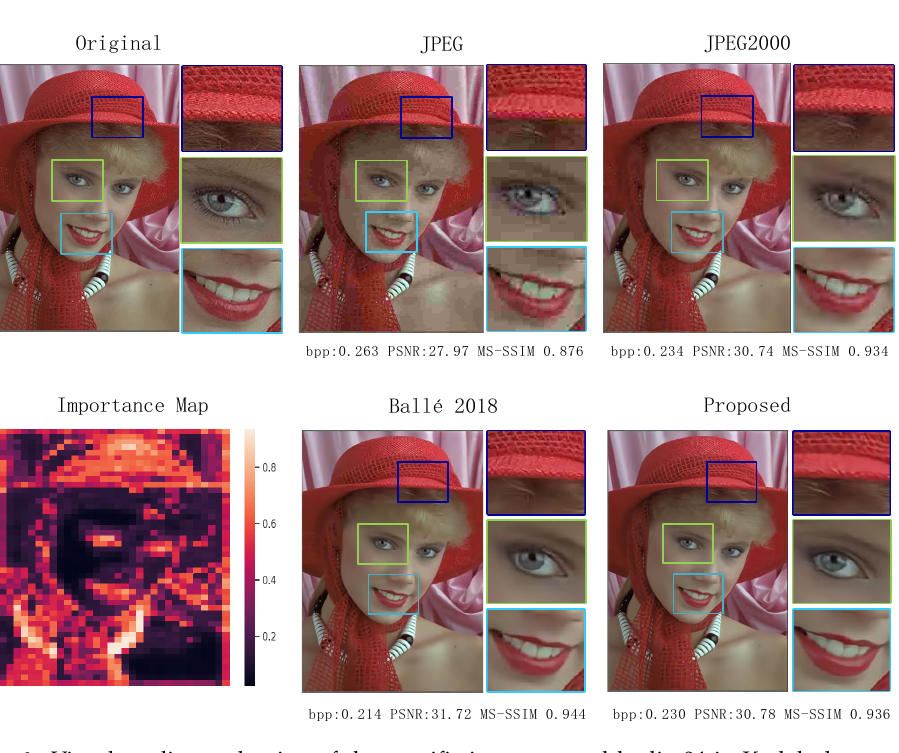
Figure 6. Visual quality evaluation of the specific image named kodim04 in Kodak dataset with different approaches.